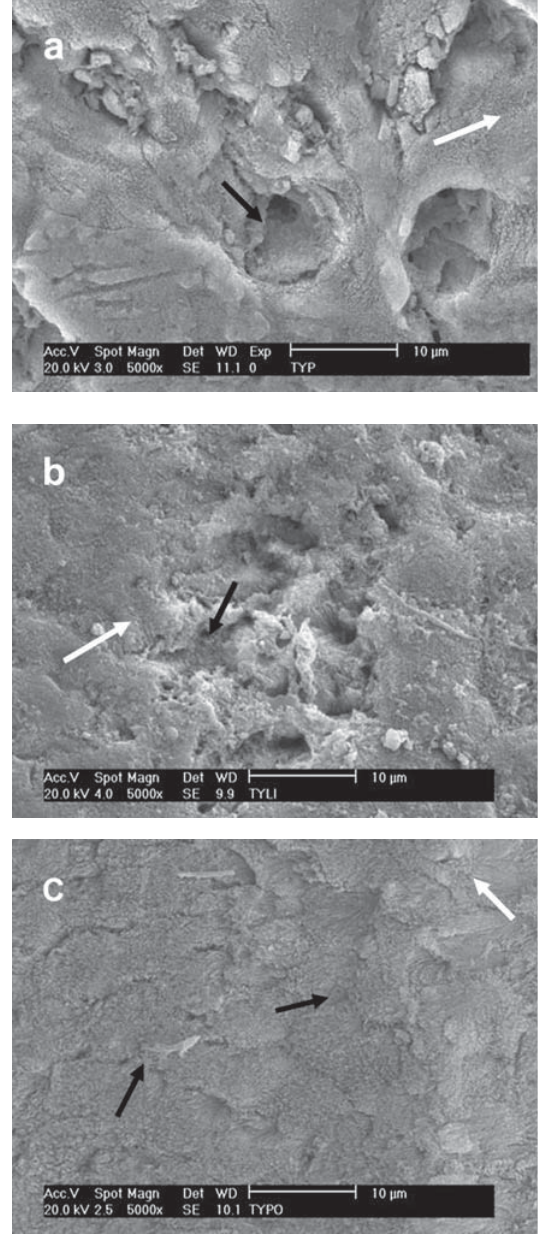
FIGURE 7- SEM micrograph of different enamel treated- groups following treatment with Tyrian SPE. a – Prophylaxis: Deep and wide holes (black arrow) along with a fine roughening (white arrow); b – SiC treatment: The fine surface roughening (white arrow) along with shallow depressions (black arrow); c – diamond bur: Note the fine surface roughening (white arrow) along with enamel rods (black arrow)